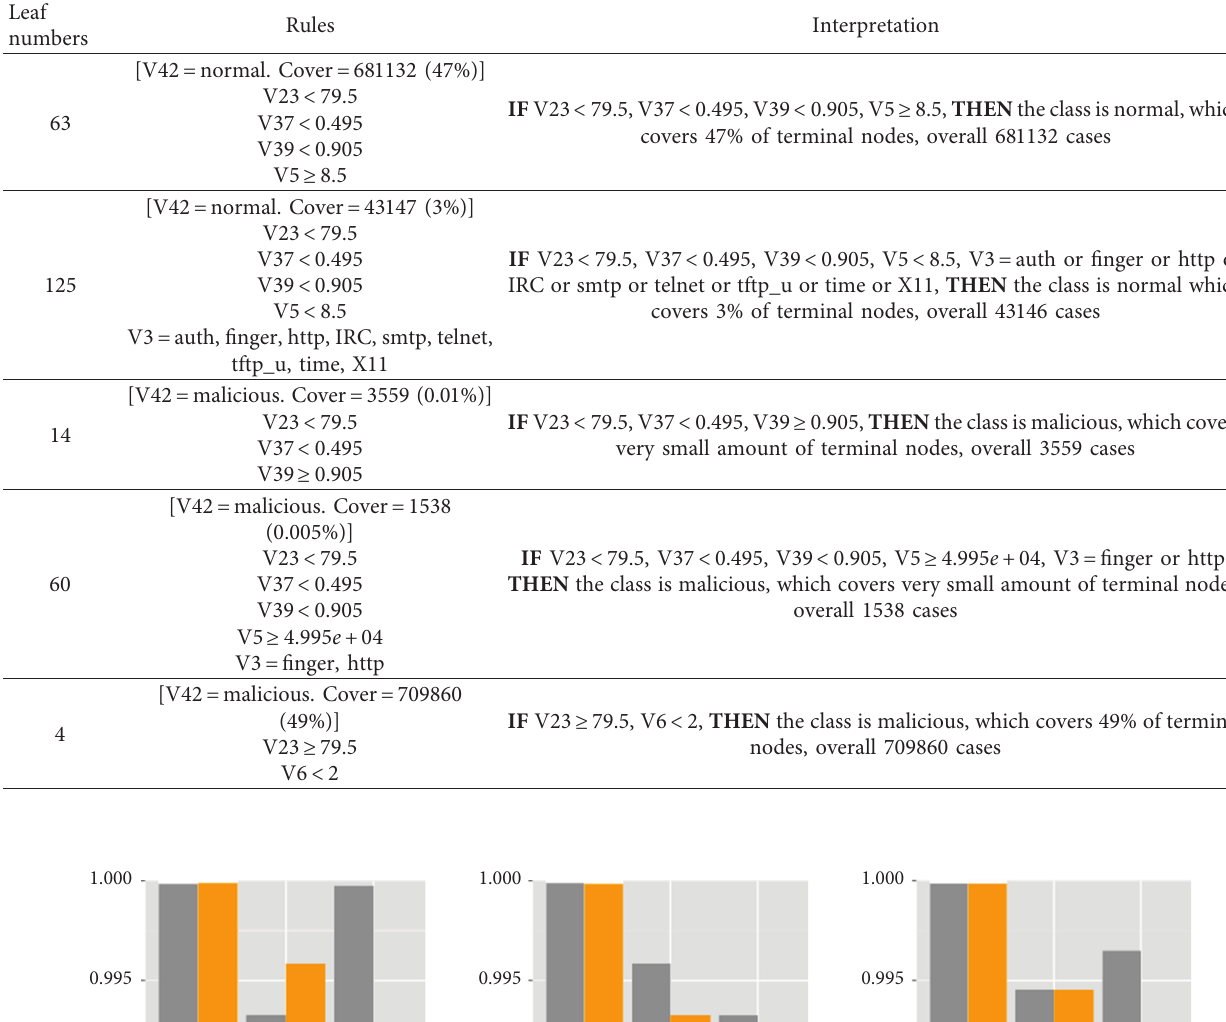
Table 3: Decision rule description from the training sets for malicious and normal nodes. The bold text is the clauses for the rules. Leaf